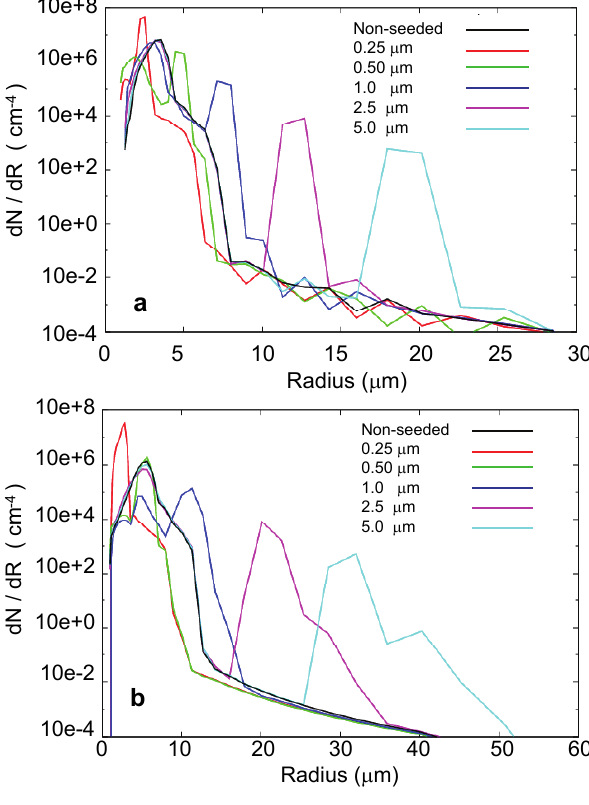
Fig. 6. Cloud droplet size distributions at 100m above the base of the cloud center for the shallow convective cloud case (updraft ve- locity is about 4ms − 1 ) at 11.5min (a) , and for the stratiform cloud case (updraft velocity is about 0.3ms − 1 ) at 68.5min (b) . The black line depicts the droplet size distribution for the non-seeded case. For seeded cases, monodisperse salt particles with five different radii are seeded under the cloud base: 0.25µm (red line), 0.5µm (green line), 1.0µm (blue line), 2.5µm (pink line), and 5.0µm (light blue line). For seeding particles of each size, the total mass is the same as the reference total mass (“ratio” =1 in Table